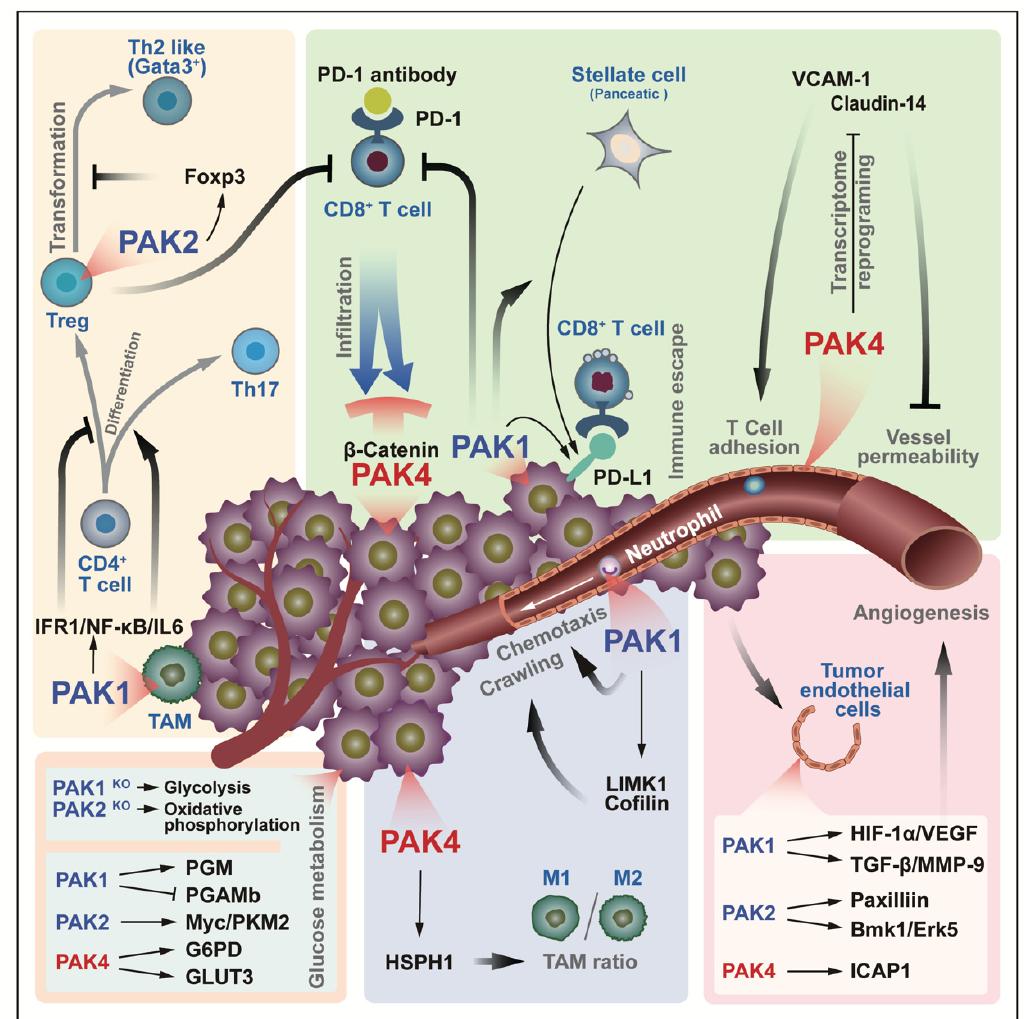
Figure 6. PAKs are involved in the interaction that occurs between the tumor microenvironment and tumor cells. PAK signaling prevents the immune system from attacking tumors in a variety of ways, such as promoting T cell adhesion to vascular endothelial cells, increasing vascular permeability, blocking CD8+ T cell infiltration into tumors, and enhancing immune escape through PD-1/PD-L1. In addition, the regulation of T cell differentiation, neutrophil chemotaxis, and tumor angiogenesis is also attributed to the participation of PAKs. PAKs regulate tumor cell glucose metabolism, including glycolysis and oxidative phosphorylation. All of the above processes are summed up in the boxes that have different background colors.